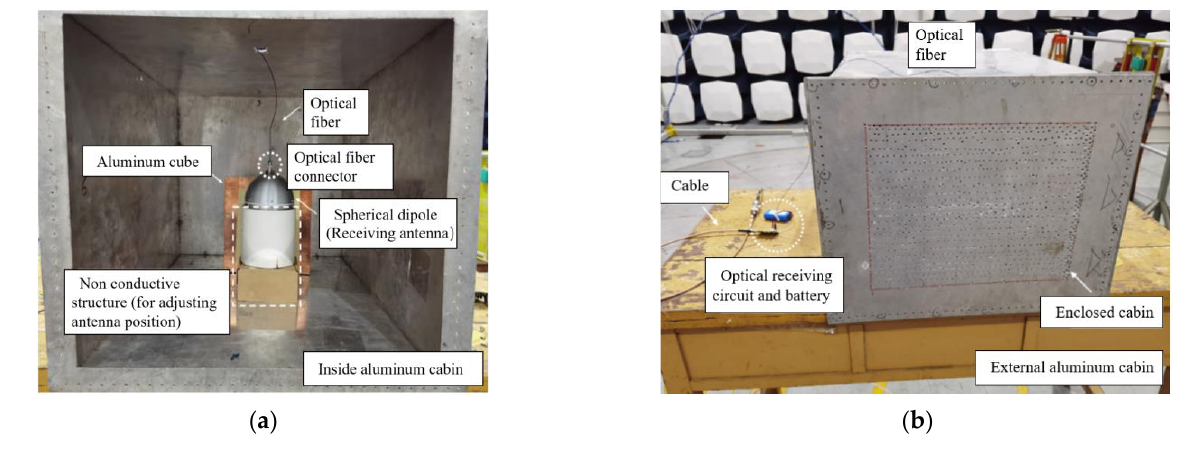
Table 3. Shielding effectiveness of point No. 1 in the center of the test cavity observation points. Figure.